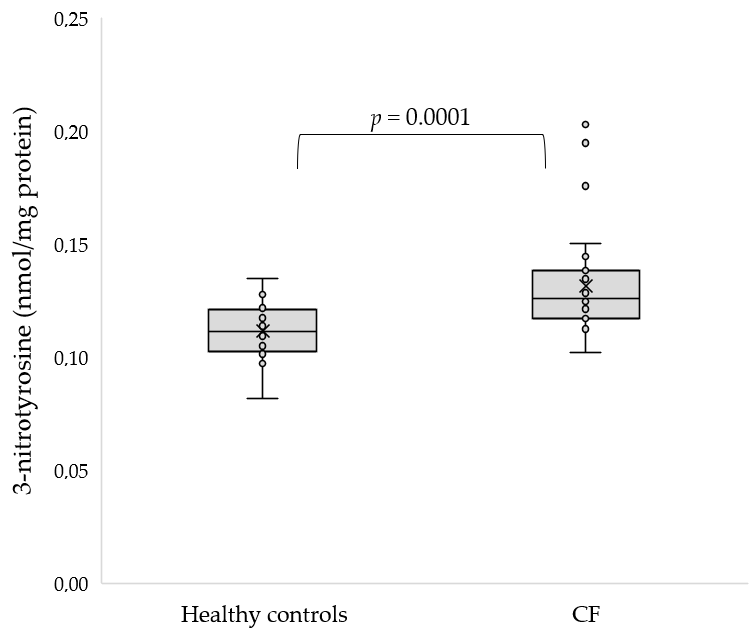
Figure 1. Concentration of 3-nitrotyrosine in serum of CF patients as compared to the control group. In addition, we used two methods to estimate the total antioxidant capacity (TAC) of the serum of the participants. The TAC of the blood serum measured by ABTS • did not show statistically significant differences with respect to the healthy controls ( p = 0.16). However, the TAC measured by FRAP was significantly lower in CF patients compared to controls (151.6 ± 28.92 vs. 170.68 ± 16.72 µ mol TE/L, p = 0.023). Lipids are very sensitive to ROS attack, and to date, malondialdehyde (MDA), 8-isoprostane and 4-hydroxy-2- nonenal (4-HNE) are the main biomarkers for lipid peroxidation assessment. An increased concentration of MDA was found in patients with CF (3.47 ± 0.5 vs. 3.17 ± 0.28 µ mol/L, p = 0.025, Figure 2).